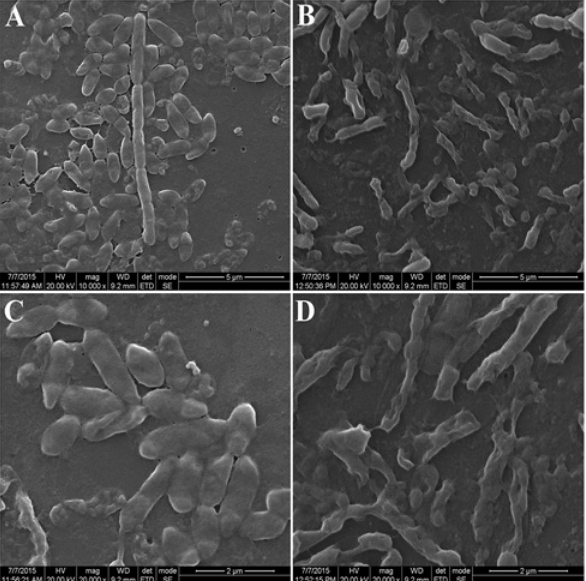
Fig 7. Scanning electron microscopy of biofilm formation: (A) Biofilm formation of control consortium cells under dark condition (B) Interacted biofilm formation at 1 μ g/ml TiO 2 -NPs under dark condition (C) Biofilm formation of control consortium under UVA condition (D) Micrograph representing the treated biofilm under UVA condition.